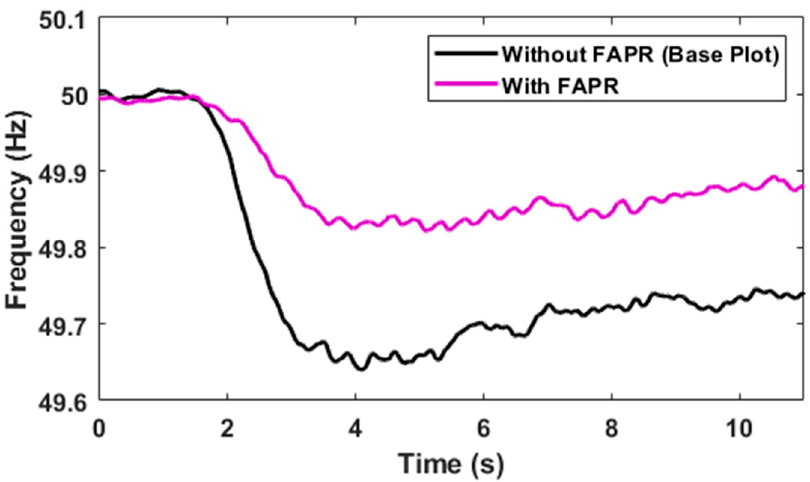
Figure 9. Dynamics of frequency due to the FAPR controller.